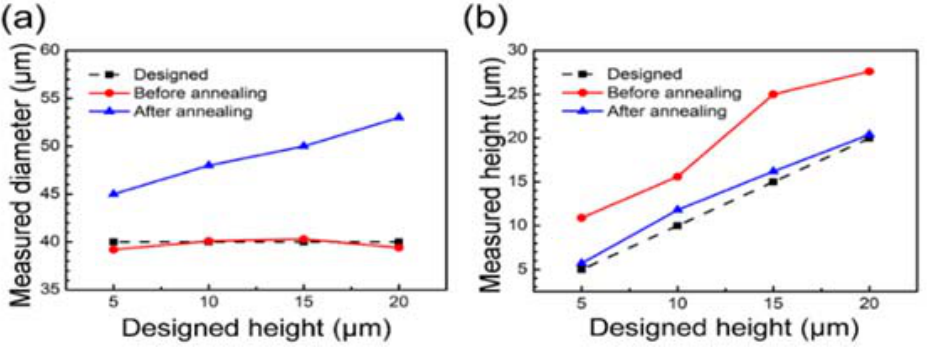
Figure 3. Variation in height and diameter of different microlenses ( a ) before and ( b ) after secondary annealing and the difference with design parameters.